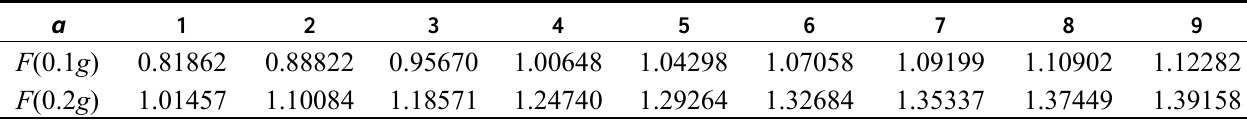
Table 2. Calculated F values for the PPA results and the Foreman model with different a